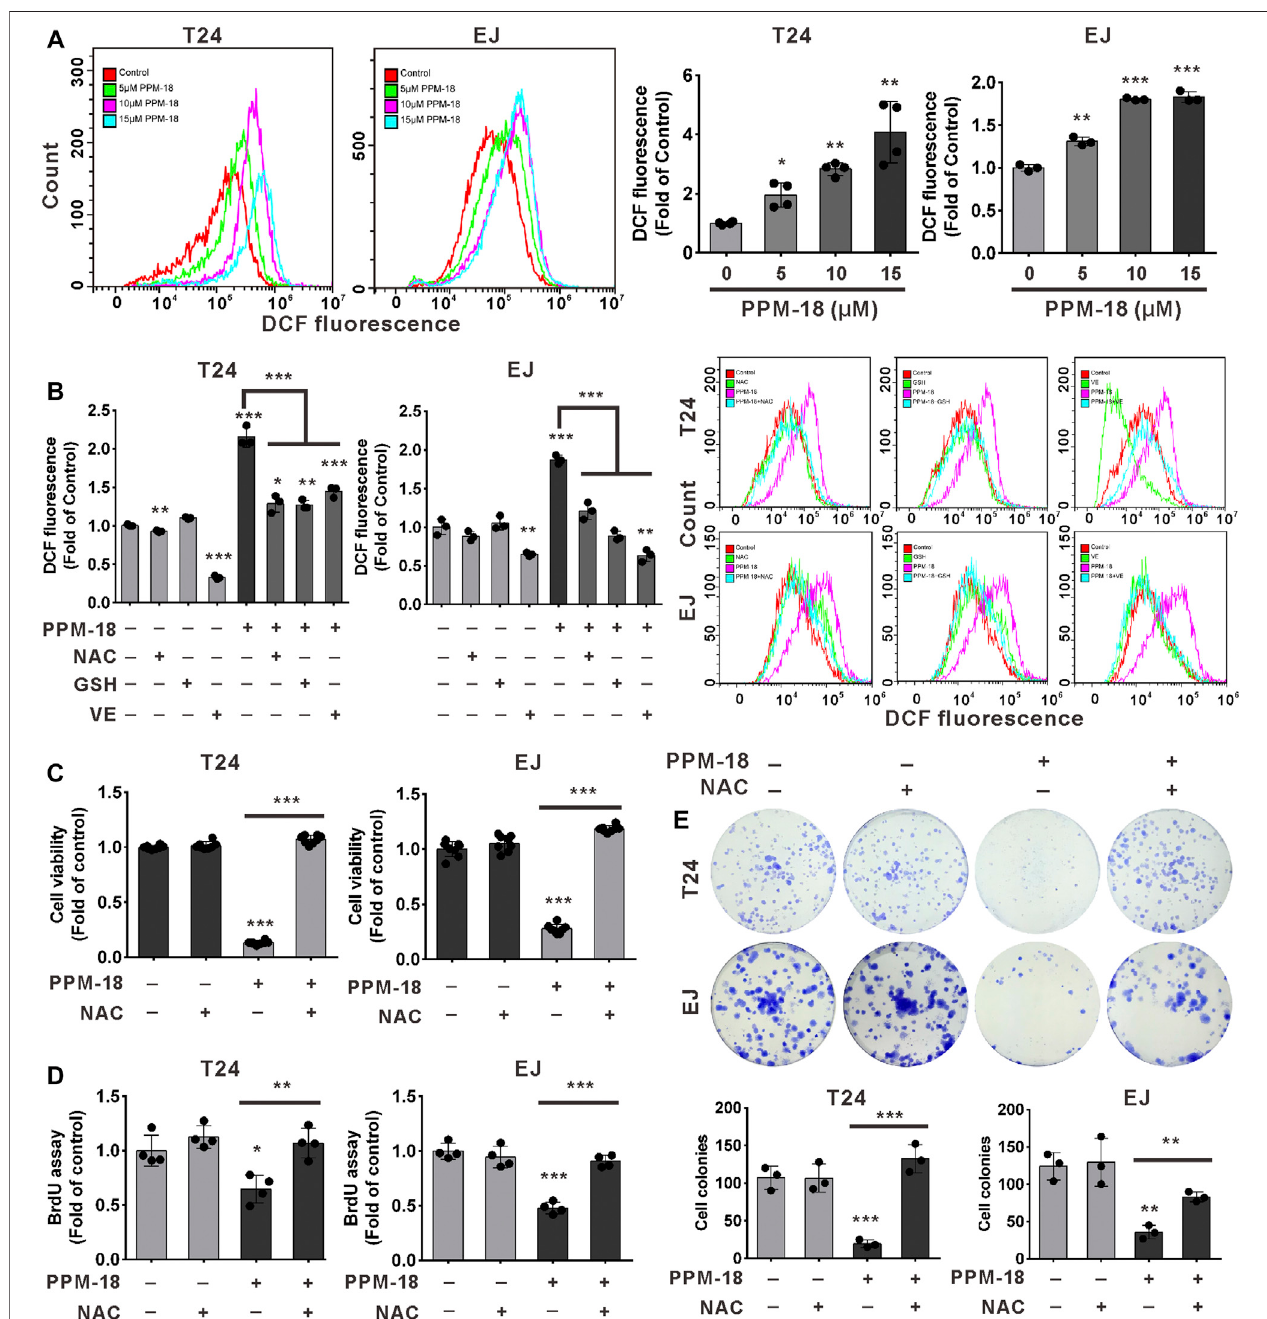
FIGURE5| PPM-18 – increasedROSgenerationleadstotheinhibitionofbladdercancercellproliferation. (A) T24andEJcellsweredose-dependentlytreatedwith PPM-18 for 12 h, and then stained with 1 μ M DCFH-DA for 30 min, and intracellular ROS generation was measured by fl ow cytometry. (B) Flow cytometry showed the impact of 6 mM NAC, 5 mM GSH, and 2 mM VE on ROS production in T24 and EJ cells treated with or without 10 μ M PPM-18 for 12 h. (C) The effect of NAC on the viability of T24 and EJ cells treated with or without PPM-18. (D) and (E) The effect of NAC on the proliferation of T24 and EJ cells treated with or without PPM-18, using BrdU and cellular colony assays. Data are presented as the mean ± SD of at least three independent experiments. * p < 0.05, ** p < 0.01, and *** p < 0.001 vs. the control group. ** p < 0.01 and *** p < 0.001 vs. PPM+NAC. *** p < 0.001 vs. PPM+GSH or vs. PPM-18+VE.